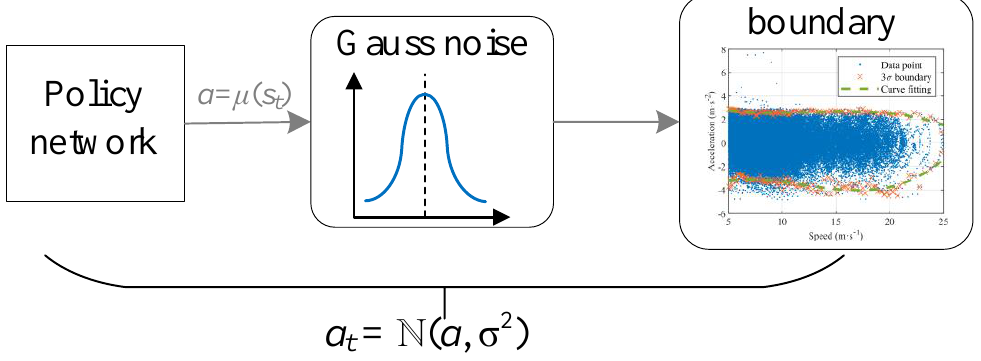
Figure 4. Random exploration and 3σ varying constraints for agent actions.